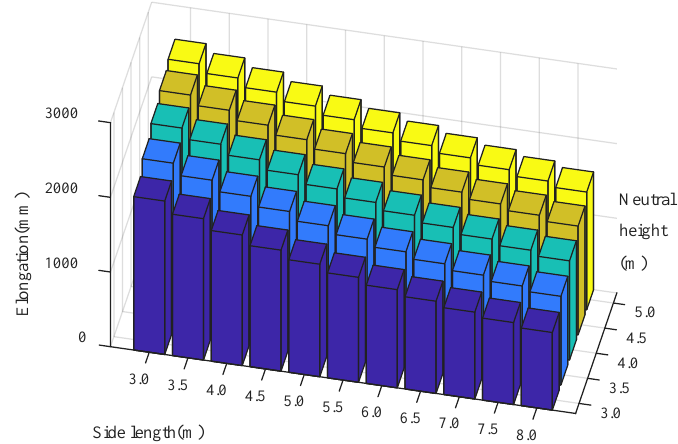
Figure 18. Correlation between branch leg elongation and neutral height under di ff erent side length circumstance.